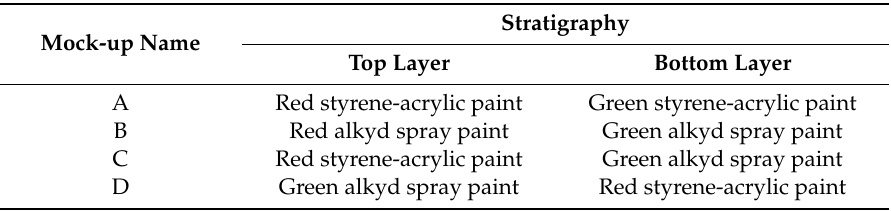
Table 1. Specimens